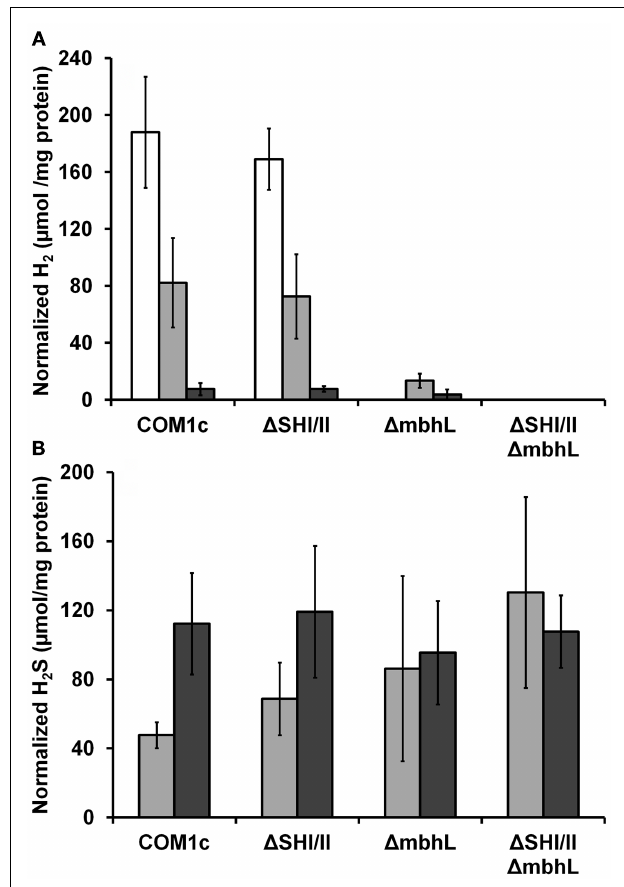
FIGURE 3 | Comparison of H 2 (A) and H 2 S (B) production by P. furiosus strains. White bars, cells grown without S 0 (no H 2 S is produced); light gray bars, cells grown with 0.5g/L S 0 ; dark gray bars, cells grown with 2g/L S 0 . The amounts of H 2 and H 2 S produced are given with respect to the total cell protein in the